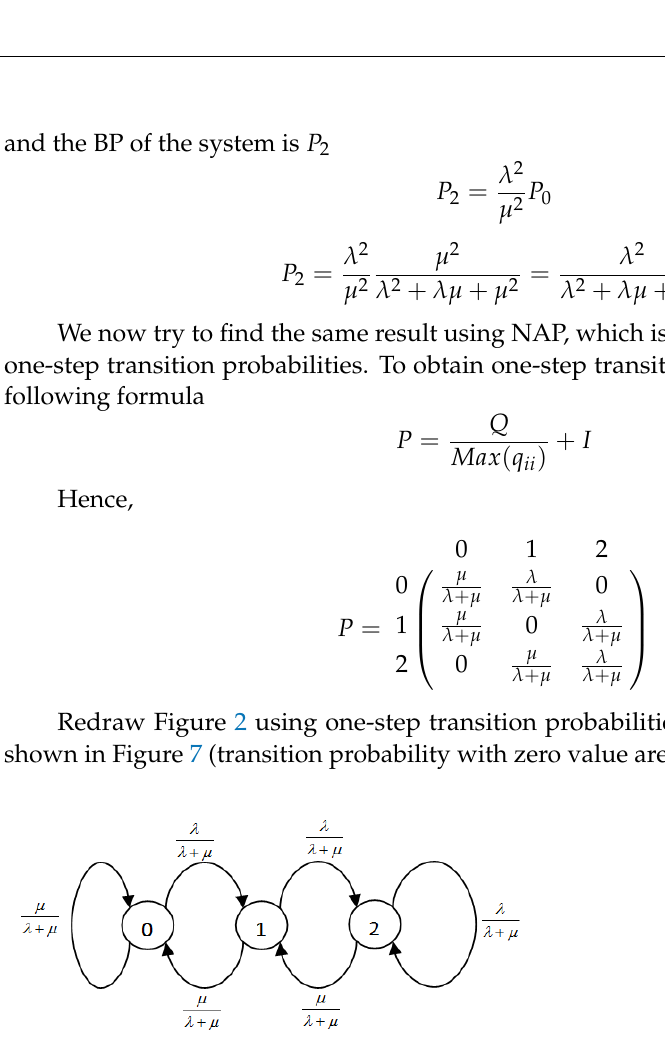
Figure 7. M/M/1/2 queue with one-step transition